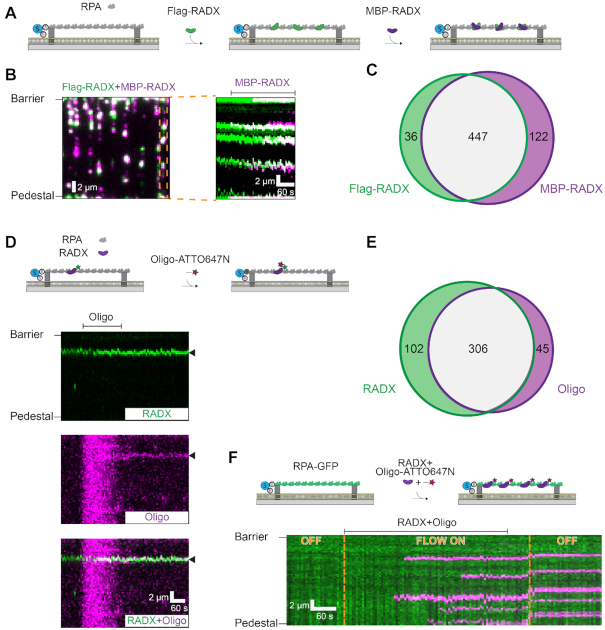
RADX bridges ssDNA via protein-protein interactions. (A) Illustration of the double-tethered ssDNA curtain assay. The ssDNA is coated by RPA and anchored between two chromium features above a lipid bilayer. (B) Left: RADX forms larger-order assemblies on RPA-coated ssDNA, as imaged via self-association of 2 nM Flag-RADX (green) and 2 nM MBP-RADX (magenta). Right: Kymograph of one molecule (orange box) indicates that MBP-RADX foci preferentially form at Flag-RADX sites. Flag-RADX was labeled with anti-Flag-Alexa488 and MBP–RADX was visualized with anti-MBP-QD705 antibodies. (C) Quantification of MBP-RADX and Flag-RADX co-localization frequency (collected from 113 ssDNA molecules). (D) A kymograph indicating that RADX directly captures non-complementary ssDNA oligonucleotides on RPA-coated ssDNA curtains. The arrows indicate where the RADX and oligo are co-localized. (E) Quantification of RADX and oligo co-localization frequency (collected from 89 ssDNA molecules). (F) A kymograph indicating that RADX preincubated with non-complementary ssDNA oligonucleotides efficiently binds on RPA-coated ssDNA curtains. The concentration of RADX and oligo injected into flowcell was 2 and 1 nM, respectively. Yellow lines: toggling buffer flow ON and OFF indicates that the oligonucleotide is stably bound on the ssDNA.